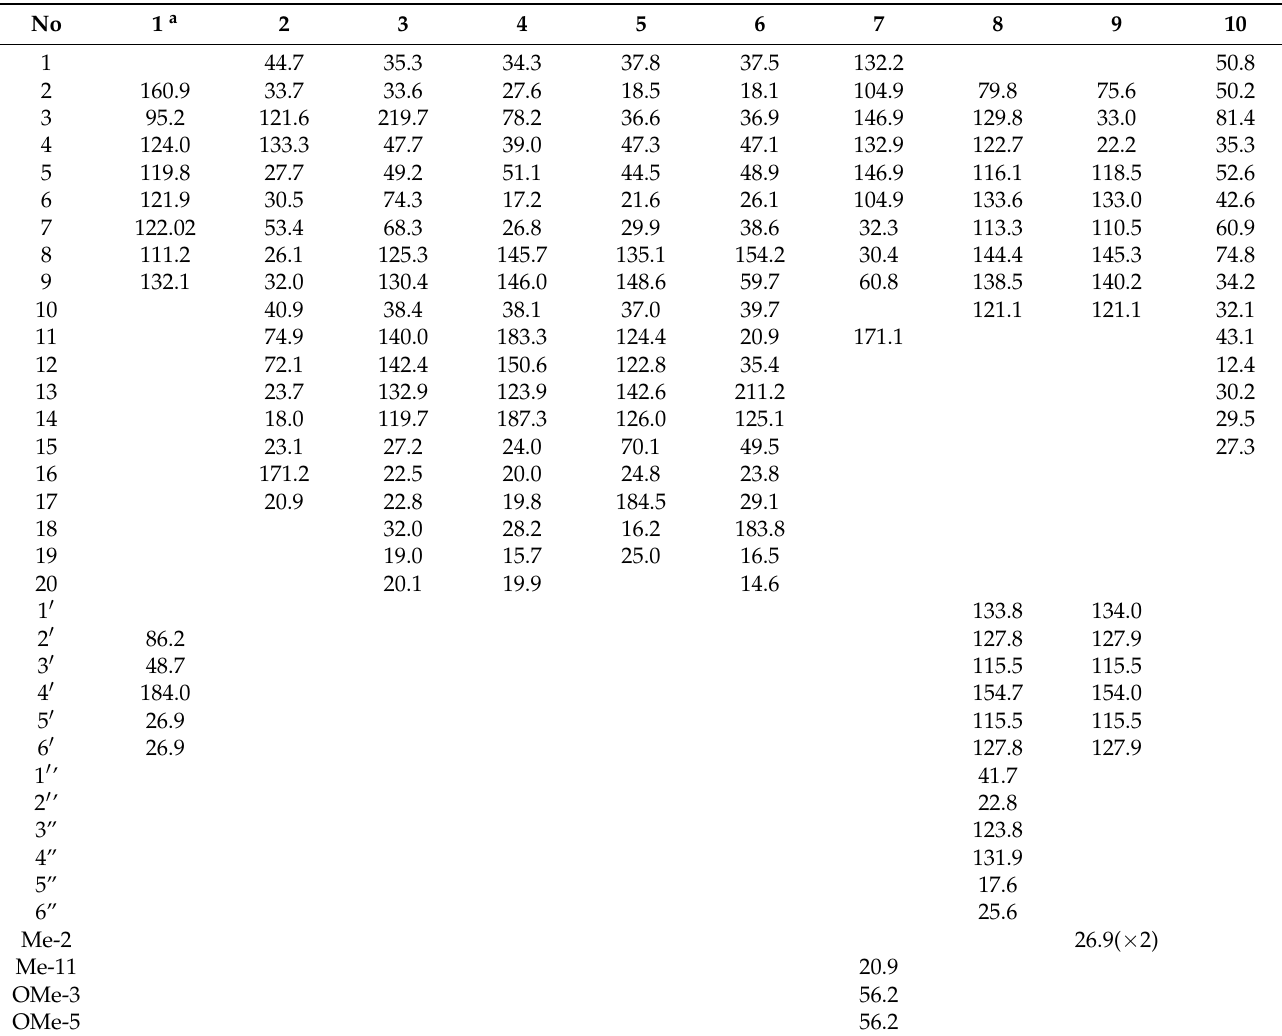
Table 2. 13 C NMR Data for Compounds 1 – 10 ( δ in ppm, 125 MHz for 13 C NMR in CDCl 3